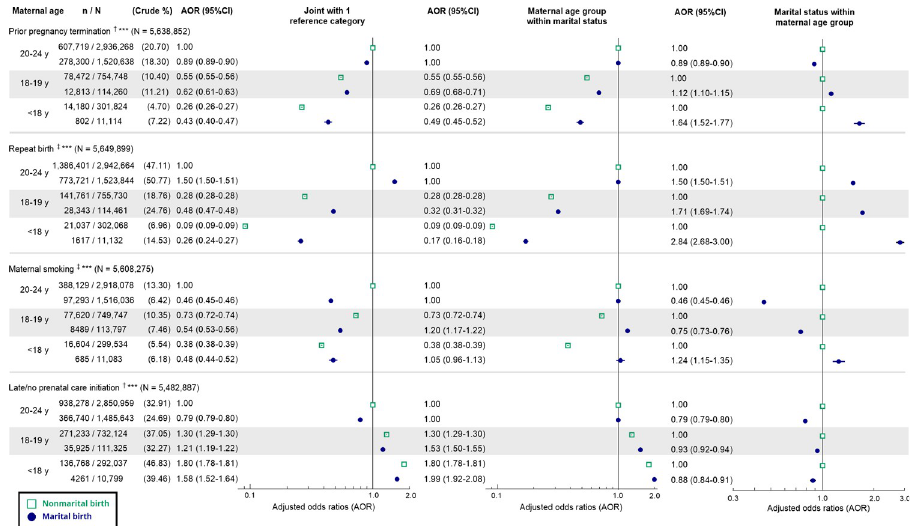
Fig 1. Adjusted odds ratios of reproductive health indicators associated with the interaction between marital status and maternal age group. AOR plotted on the logarithmic scale. † Adjusted for maternal race/ethnicity, maternal US-born status, parity, paternal age, WIC benefits received, Medicaid as main payor of the delivery, and birth year. ‡ Adjusted for maternal race/ethnicity, maternal US-born status, paternal age, WIC benefits received, Medicaid as main payor of the delivery, and birth year. ��� p < 0.001 for interaction term between marital status and maternal age group. AOR, adjusted odds ratio; WIC, Special Supplemental Nutrition Program for Women, Infants, and